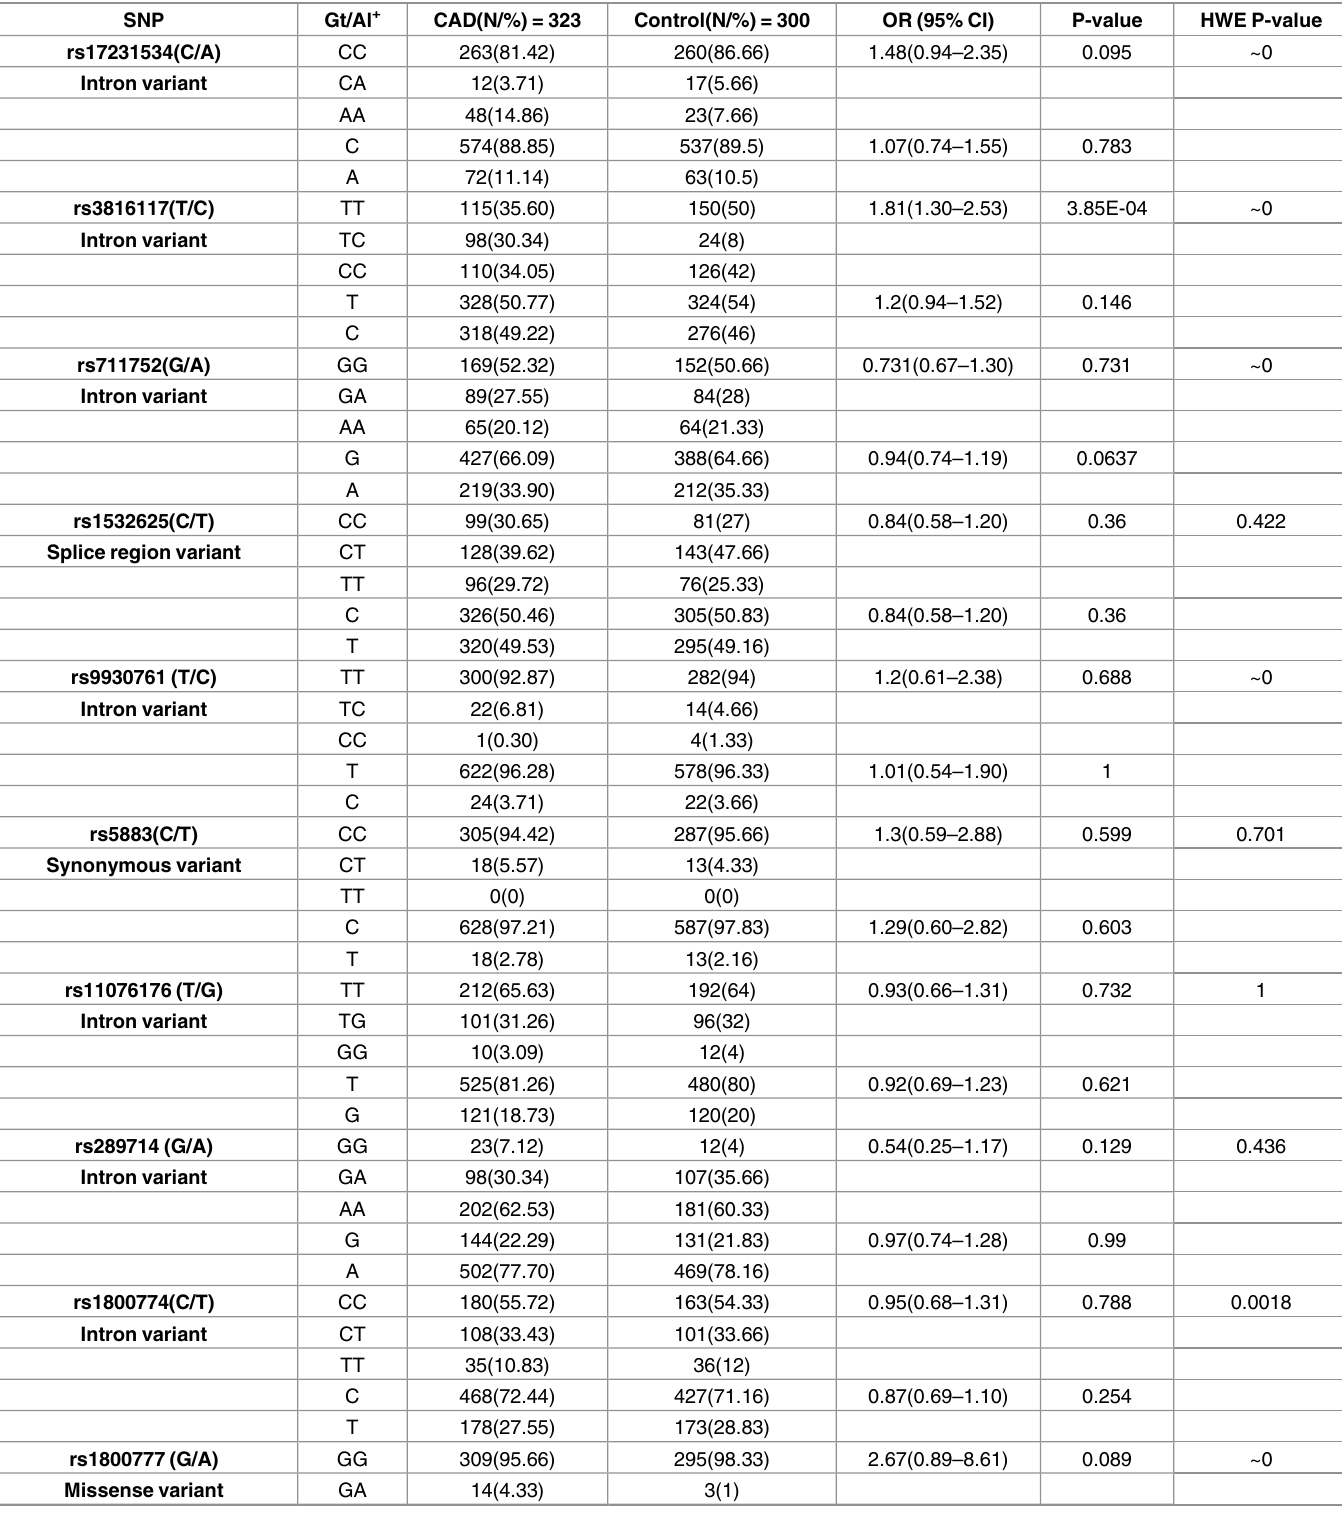
Table 3. Genotype and allele frequency distributions of SNPs in CETP among cases and